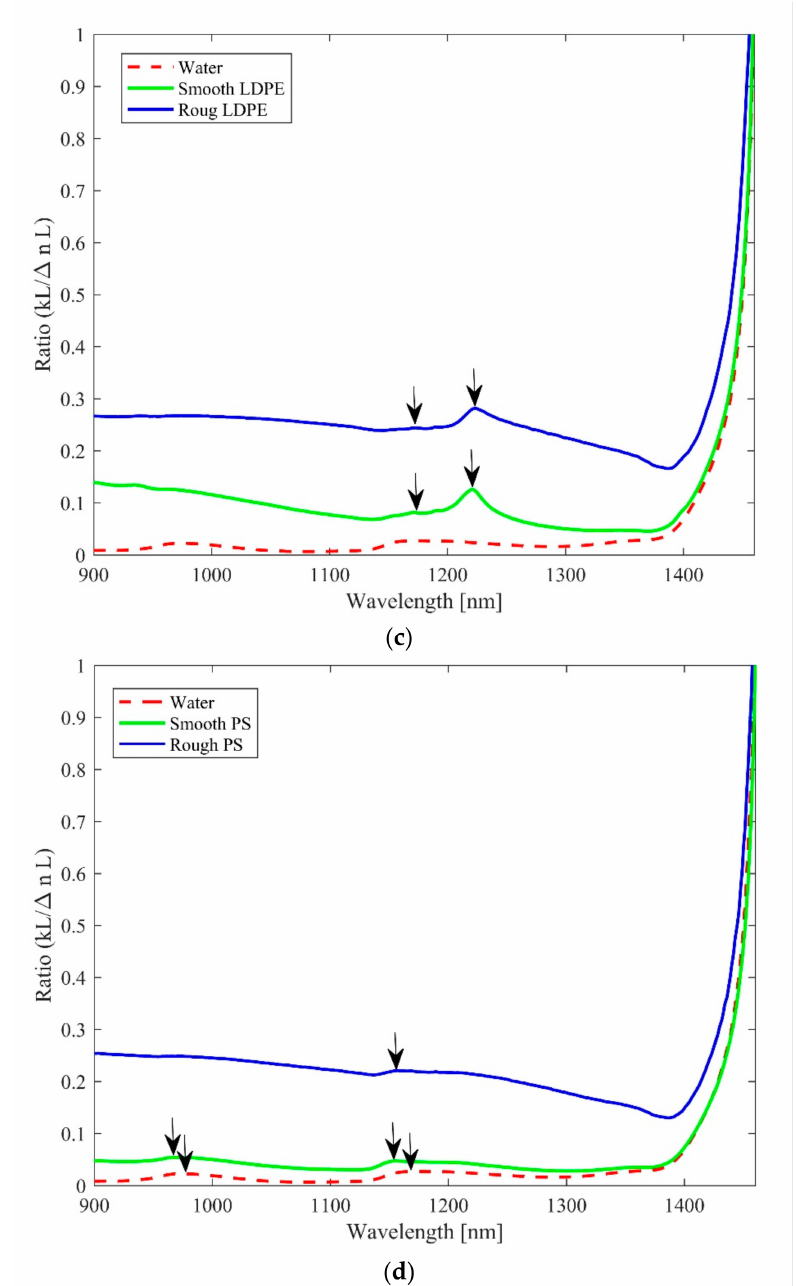
Figure 3. Ratio ( σ ) curves for smooth and rough macroplastics embedded in water. The short arrows indicate the peaks ( a ) PA type; ( b ) PP type; ( c ) LDPE type; ( d ) PS